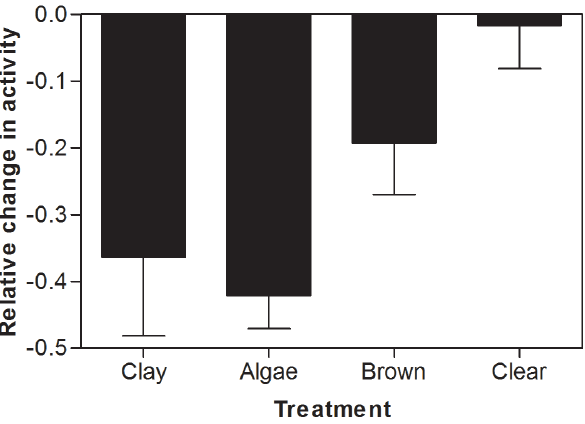
Figure 2. Relative change in swimming activity (mean 6 standard error) in crucian carp upon experiencing chemical cues from a pike. Clay, algae and brown water treatments represent a visual range of 40 cm created by the different substances, whereas clear water is a control with no visual deterioration.